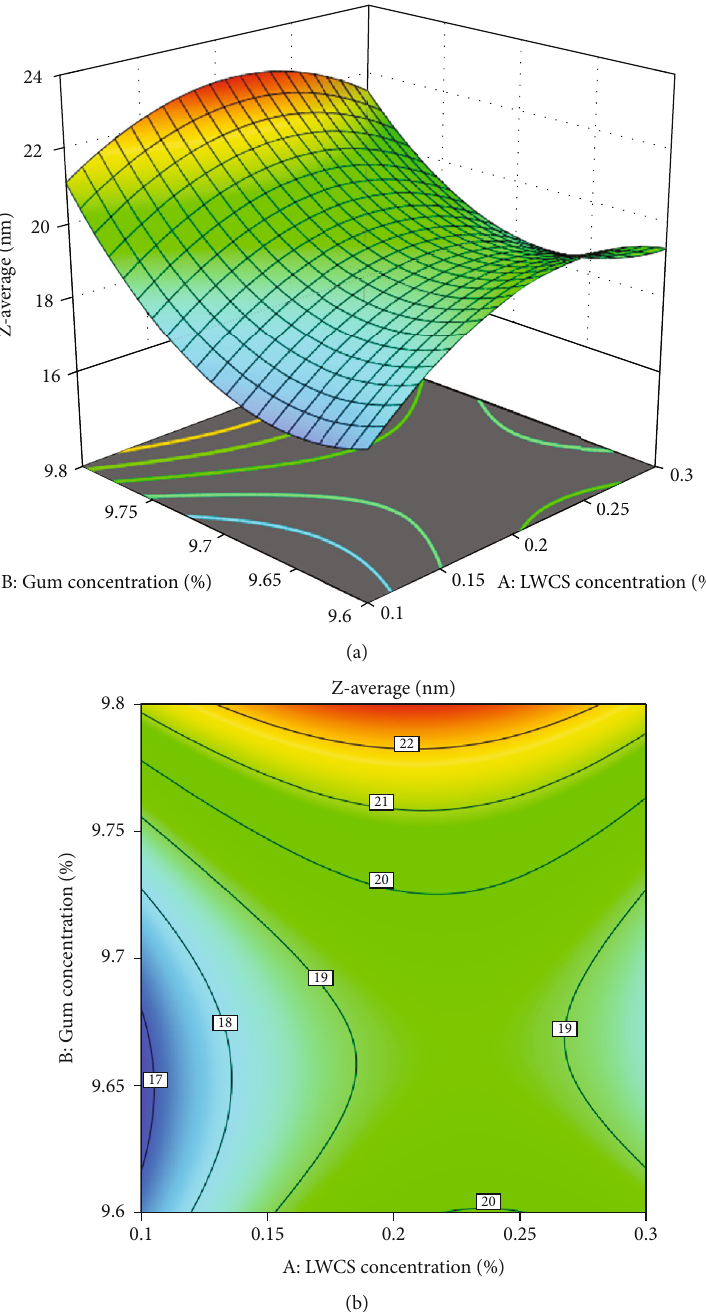
Figure 1: Surface plot (a) and contour plot (b) for Z -average